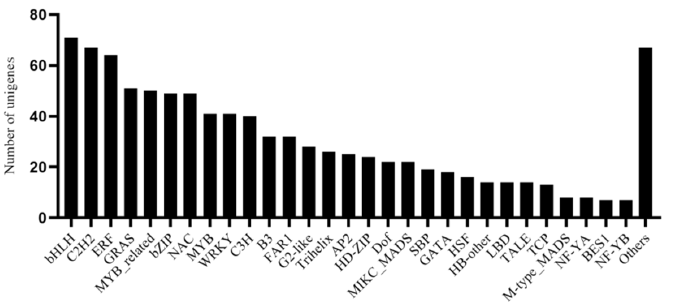
Figure 7. Classification of transcription factor families by analysis of the G. macrophylla transcrip- tome.